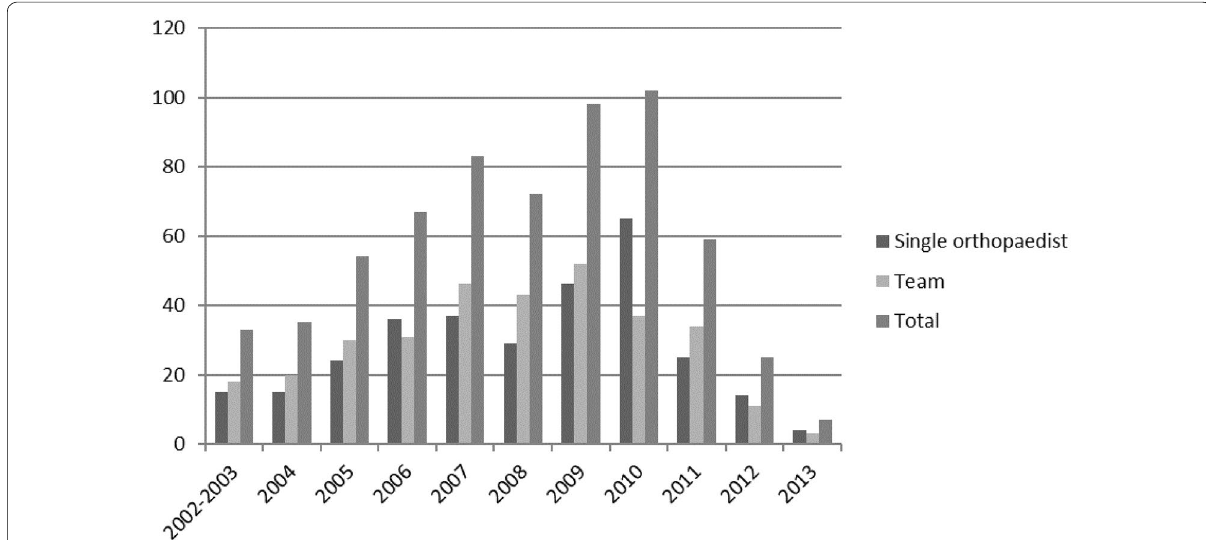
Fig. 1 Historical trend in alleged orthopedic malpractice